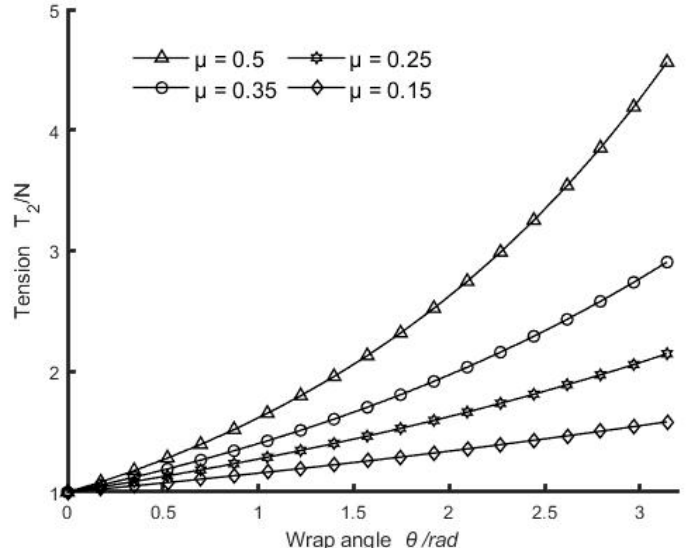
Figure 7. The change of output tension T 2 with the wrap angle under different friction coefficients. Due to the structural size limitation of surgical instruments (the radial dimension of an operating rod and end-effector is generally not greater than 10 mm), the radius ratio of the guide pulley and the cord is usually less than 40 [33]. Therefore, to analyze the influence of the radius ratio k of the guide pulley on the cord, the values of the radius ratio k were selected as 40, 20, 10, and 5, and output tension T 2 was tested under the different radius ratios k. As shown in Figure 8, the tension loss of the cord increases with the increase in radius ratio k. Therefore, to reduce the tension change of the cord, the radius ratio k should be reduced as much as possible; that is, the diameter of the guide pulley should be reduced as much as possible. However, if the radius ratio k is too small, the bending stress of the cord will be increased, which can easily lead to fatigue breakage of the cord. Therefore, the diameter of the guide pulley should be reduced as much as possible in the design, and the bending stress of the cord should be checked at the same time. To avoid the problem of discontinuous contact between the cord and guide pulley, the range of tension inclination angle ω should be limited to ω < π /2 [34]. In addition, to avoid the relaxation of the cord, the cord needs a certain pre-tightening force. Therefore, the tension inclination angle ω is generally small. To analyze the influence of the tension inclination angle on the cord tension, tension inclination angles ω = 20 ◦ , 10 ◦ , 5 ◦ , and 0 ◦ were taken respectively in the verification process. As shown in Figure 9, output tension T 2 increases with the increase in tension inclination angle. This is because the larger the tension inclination angle, the larger the bending stiffness EI of the cord. According to the moment of inertia formula, I = π d4/64, where d is the diameter of the cord. Therefore, to reduce the influence of the tension inclination angle, a cord with a smaller diameter should be selected as far as possible in order to satisfy the structural requirements and transmission